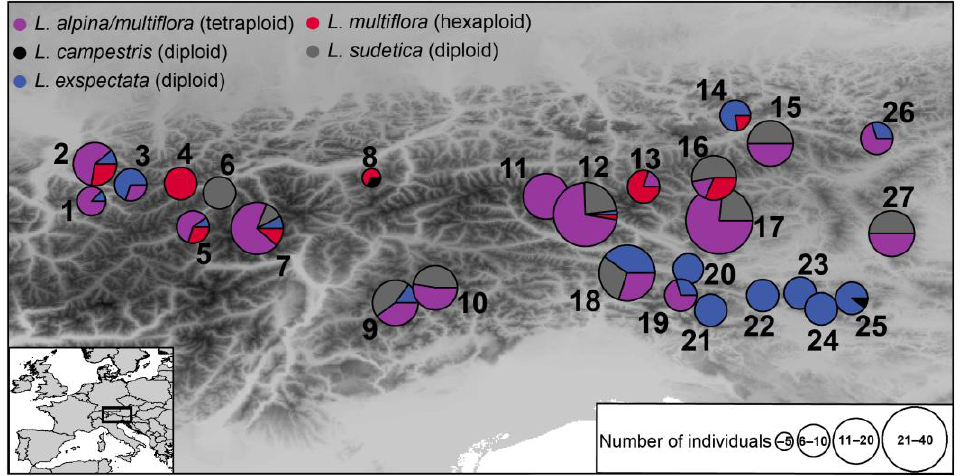
Figure 3. Sampling localities of Luzula alpina/L. multiflora , L. campestris , L. exspectata , L. multiflora and L. sudetica . Sizes of pie charts are proportional to the number of sampled individuals per locality; colors indicate the proportions of the sampled taxa. Locality numbers correspond to Table S1.